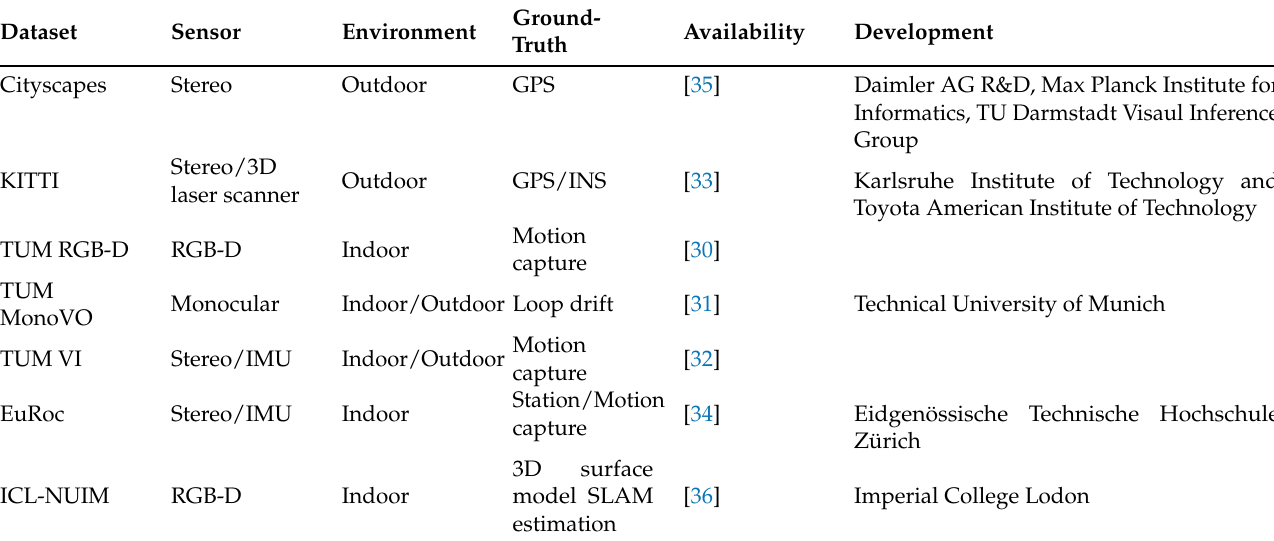
Table 1. Common open-source datasets for